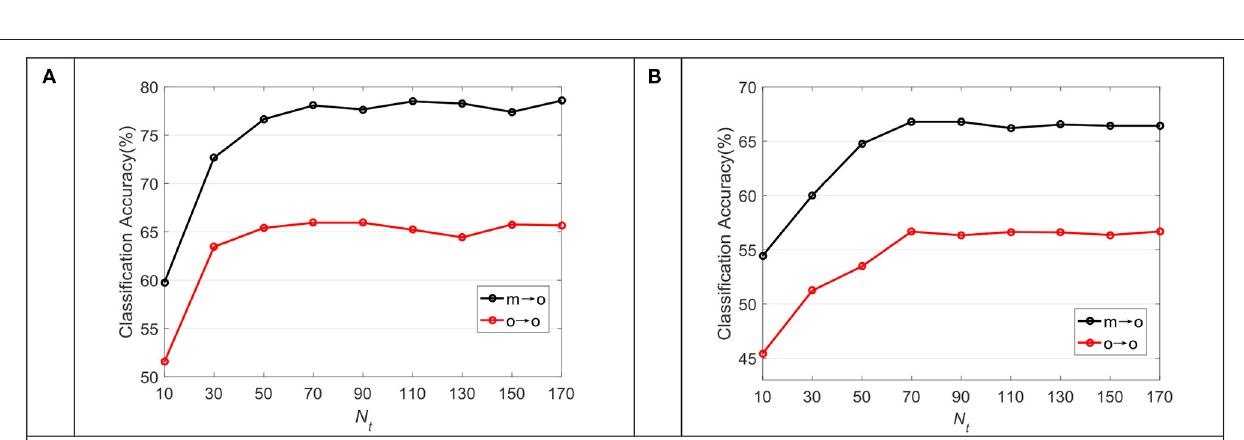
Frontiers in Psychology |